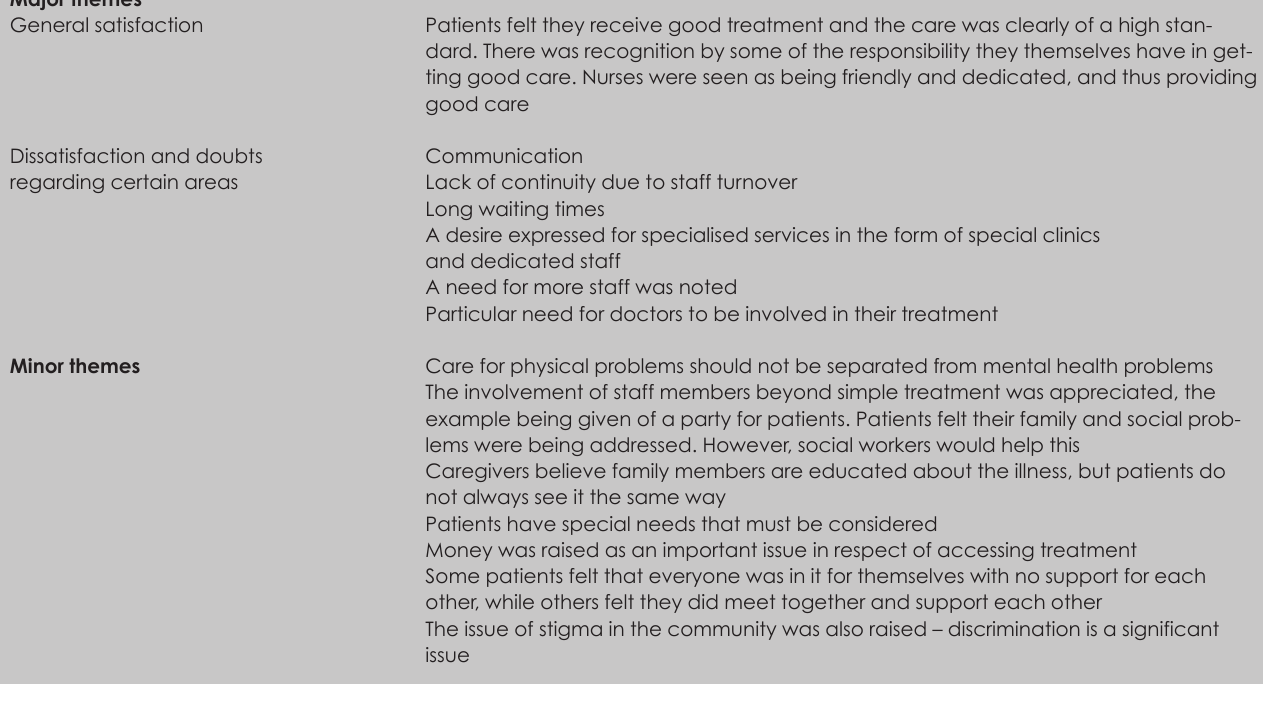
Fig. 1. Satisfaction versus dissatisfaction with mental health